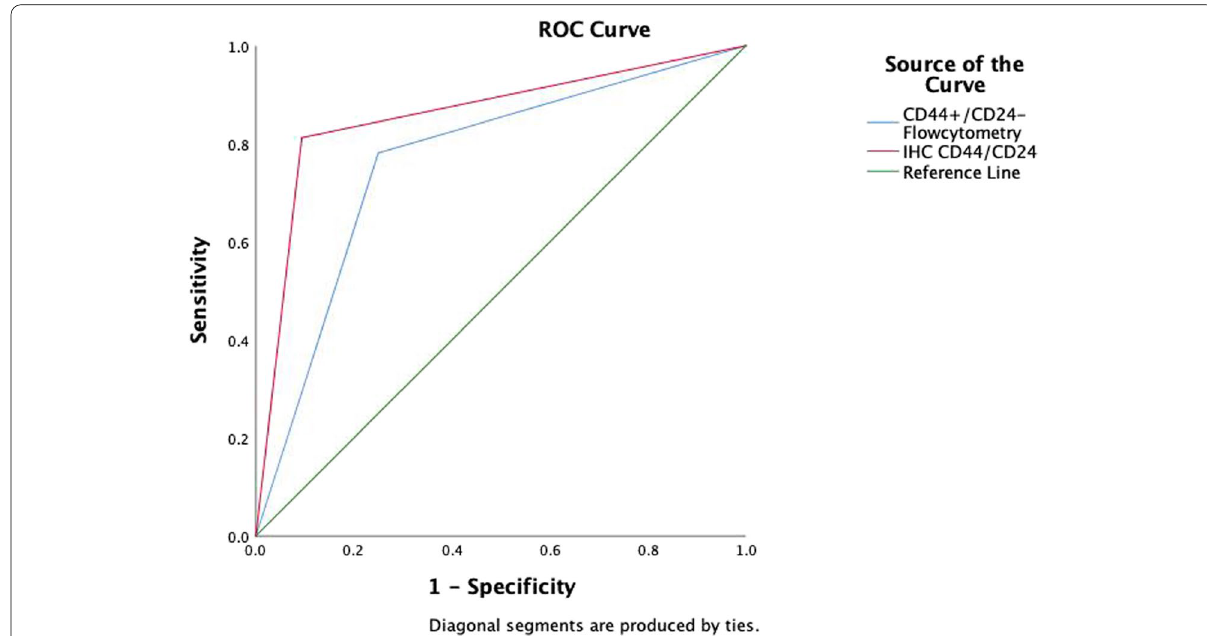
Fig. 4 ROC curve of CSCs immunohistochemistry (red line) and flow cytometry (blue line). The red line is further to the reference means that immunohistochemistry had a better ROC curve